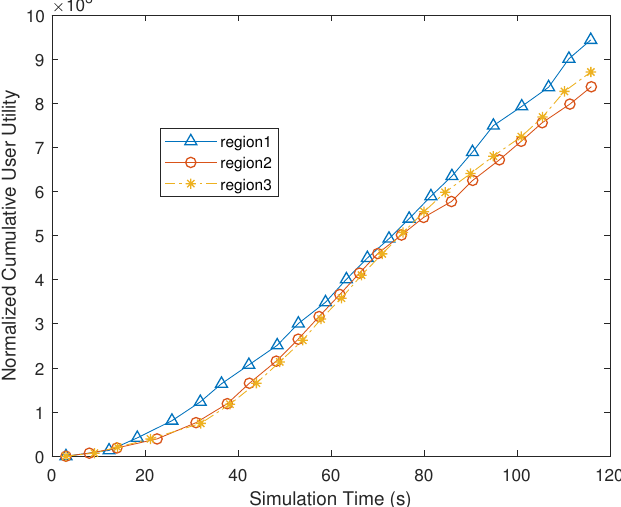
Figure 5. Cumulative user utility in different